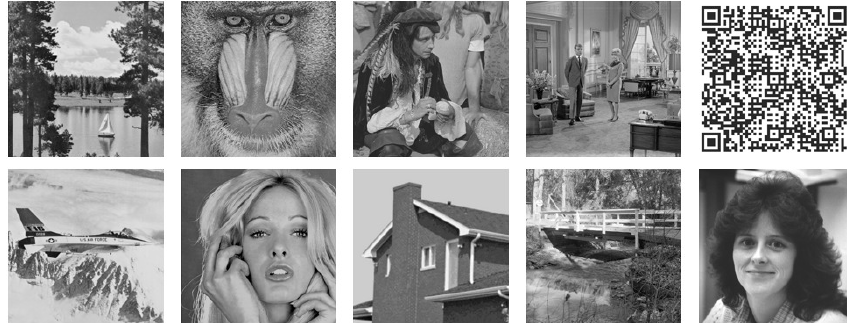
Figure 5. Ten object images employed for generating training holograms.